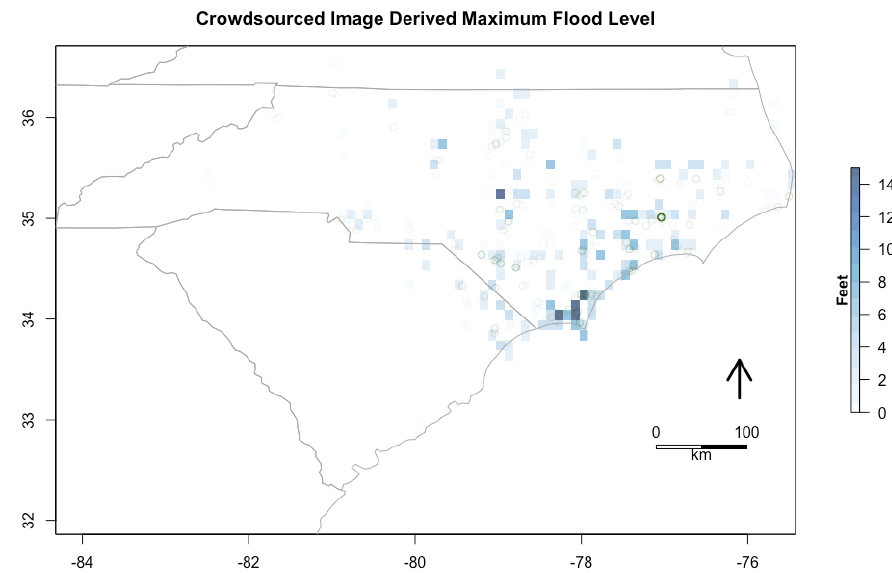
Figure 1. Raster visualization and location symbols of flood depths derived from crowdsourced